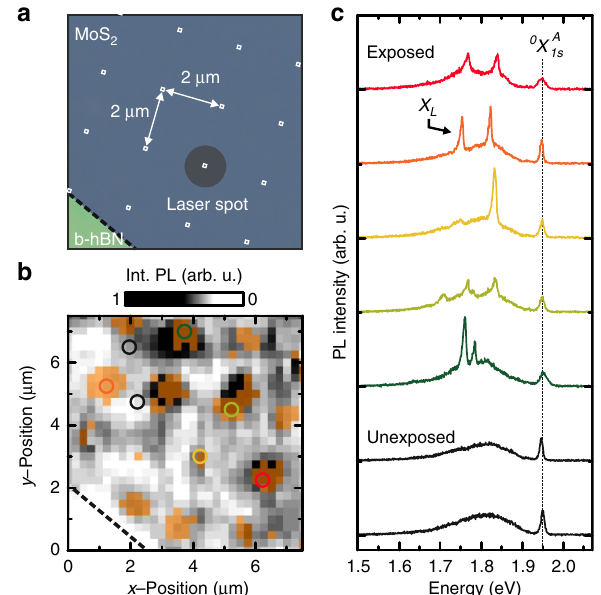
Fig. 2 Site-selective generation of defect emission by helium ion exposure. a Optical micrograph of the monolayer MoS 2 /hBN van der Waals heterostructure prior to helium ion exposure and full encapsulation. A matrix of 100 × 100 nm fi elds is exposed with a pitch of 2 μ m. A dose of σ = 2.2 × 10 12 cm − 2 is used. b Corresponding spatially resolved and spectrally integrated PL mapping (grayscale) at 10 K. Spectra are integrated for Δ E = (193 ± 5) meV. The spatial occurence of emitters in the range Δ E L ~ 100 – 220 meV is overlayed in orange. c Selected spectra taken from b are shown. All spectra reveal emission from 0 X A while only irradiated areas 1 s reveal emission from localized states X L . The defect emission is absent in unexposed areas (black spectra and corresponding circles in b